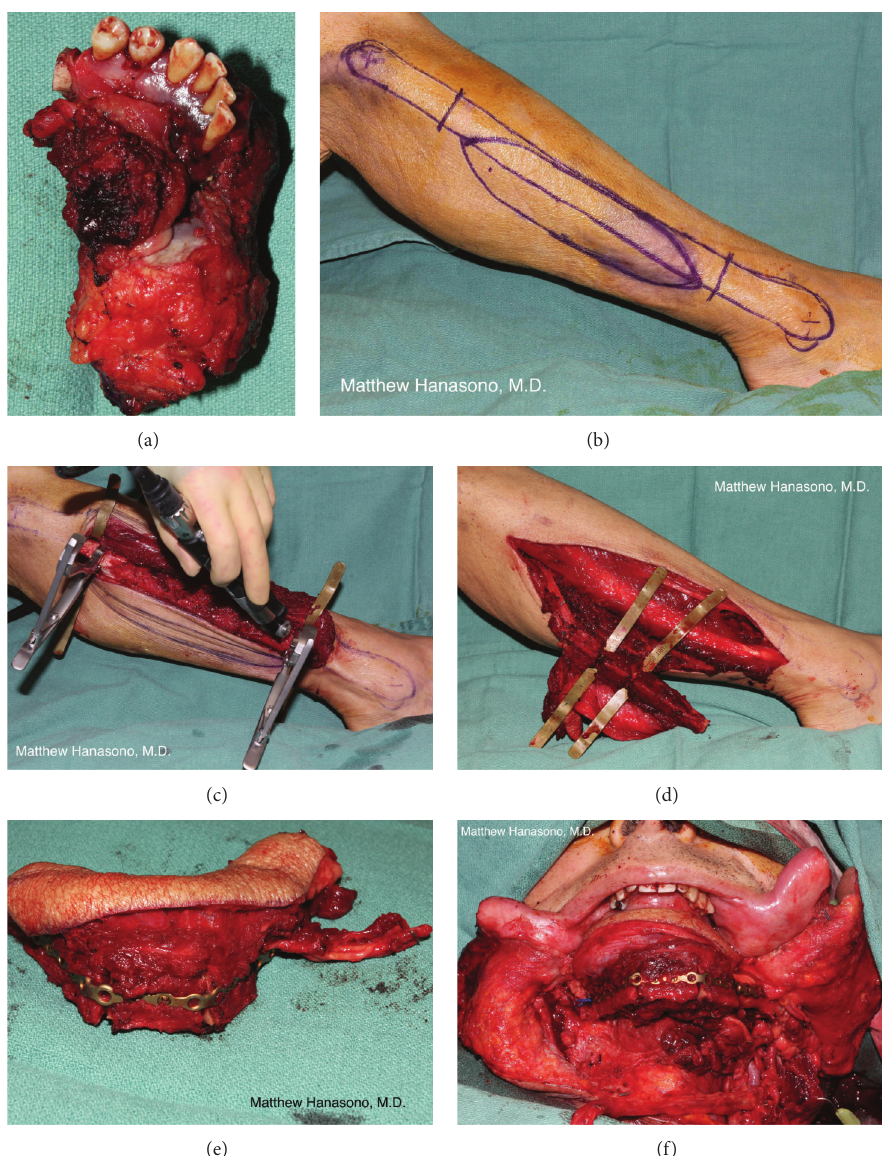
Figure 4: Composite anterior mandibular resection for a large invasive floor of mouth cancer (a). Skin markings for a fibula osteocutaneous free flap (b). Approximately 5 to 7 cm of proximal and distal bone are left in situ (c). Osteotomies for shaping the fibula can be made prior to or after pedicle division (d). Fibula osteocutaneous free flap after rigid fixation with a titanium reconstruction plate (e). Flap inset